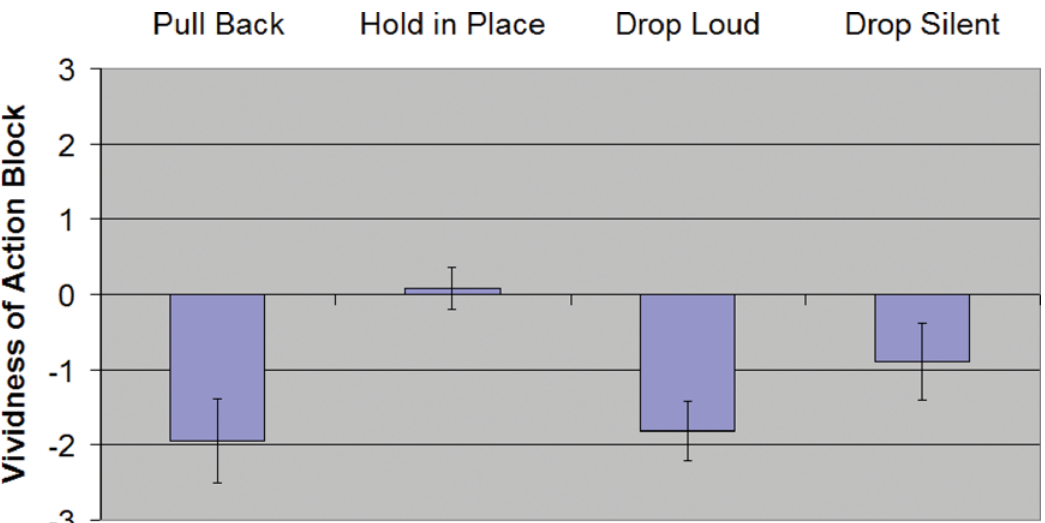
Fig 11. Relative vividness ratings for Experiment 2. Error bars are SEM. Y-axis is the reported vividness of the action block relative to the vividness of the stationary block after the condition's action was performed. Negative values mean the action block was less vivid or faded more than the stationary (control) block.